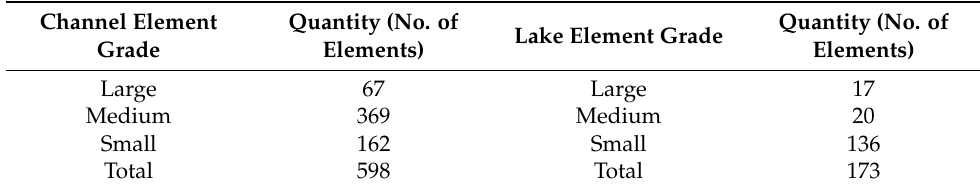
Table 9. Grading results for the Baiyangdian river system network elements.